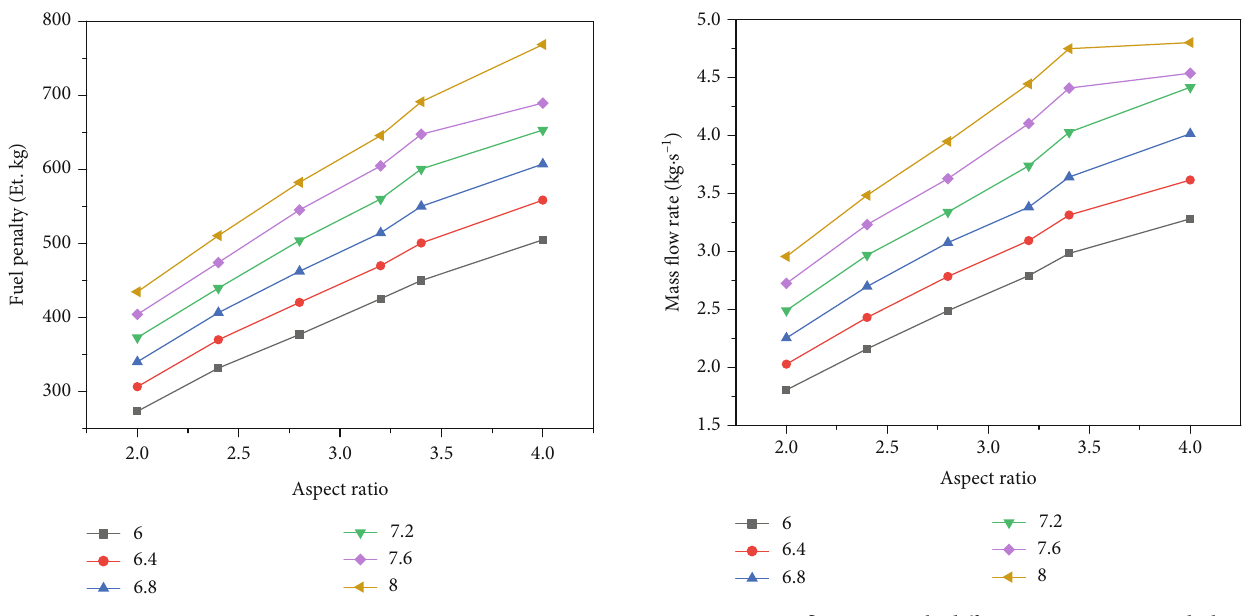
Figure 4: Fuel penalty with di ff erent aspect ratios and slope angles at an opening length of 1460mm.